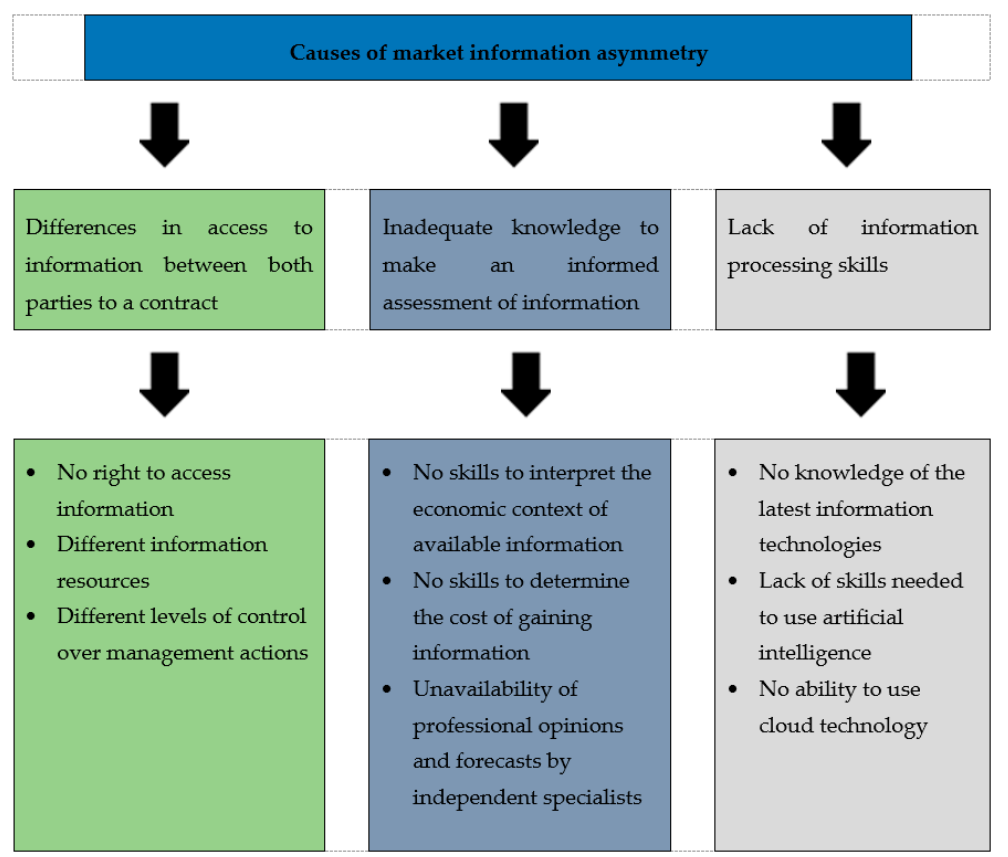
Figure 1. Causes of market information asymmetry.